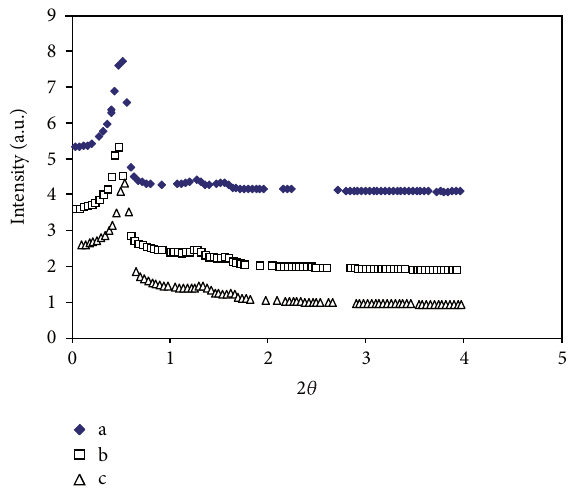
F 2: XDR diffraction patterns (small angle) of SBA-15 loaded with valproic acid. (a) SBA-15-(1:15)-VA; (b) SBA-15-VA; (c) SBA-